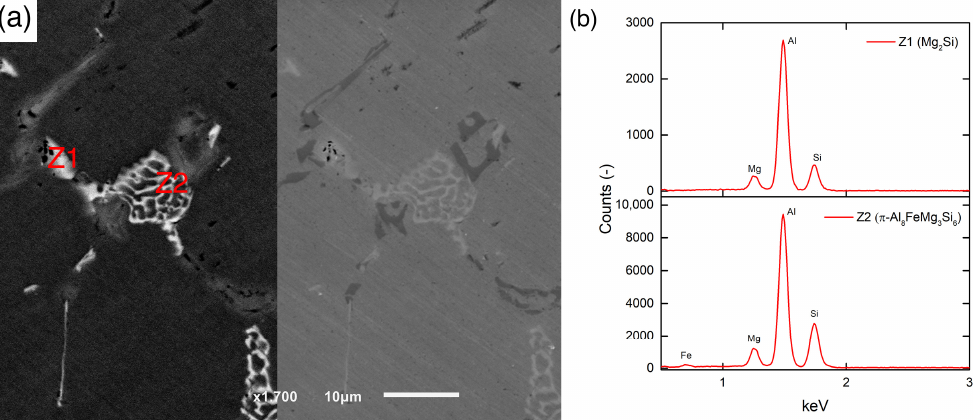
Figure 6. ( a ) Detailed SEM (BSE/SE mode) micrograph of Mg2Si (Z1) growing on π -phase (Z2) in sample C ( b ) EDS analysis of corresponding intermetallic identified as Z1 and Z2.